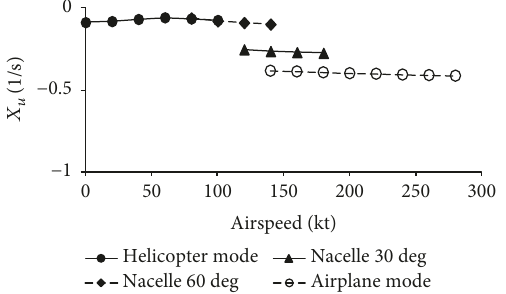
Figure 10: Variation of the derivative X